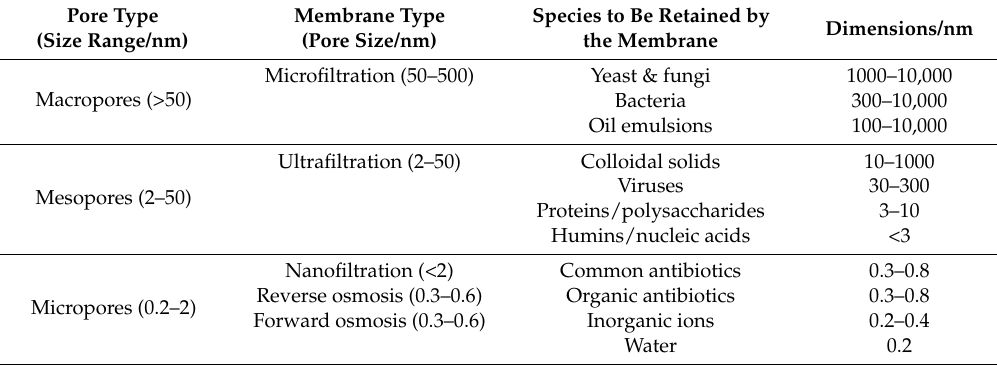
Table 2. Types of membranes applicable for resource recovery in the biotechnological industry (Adapted from [21] with permission from The Royal Society of